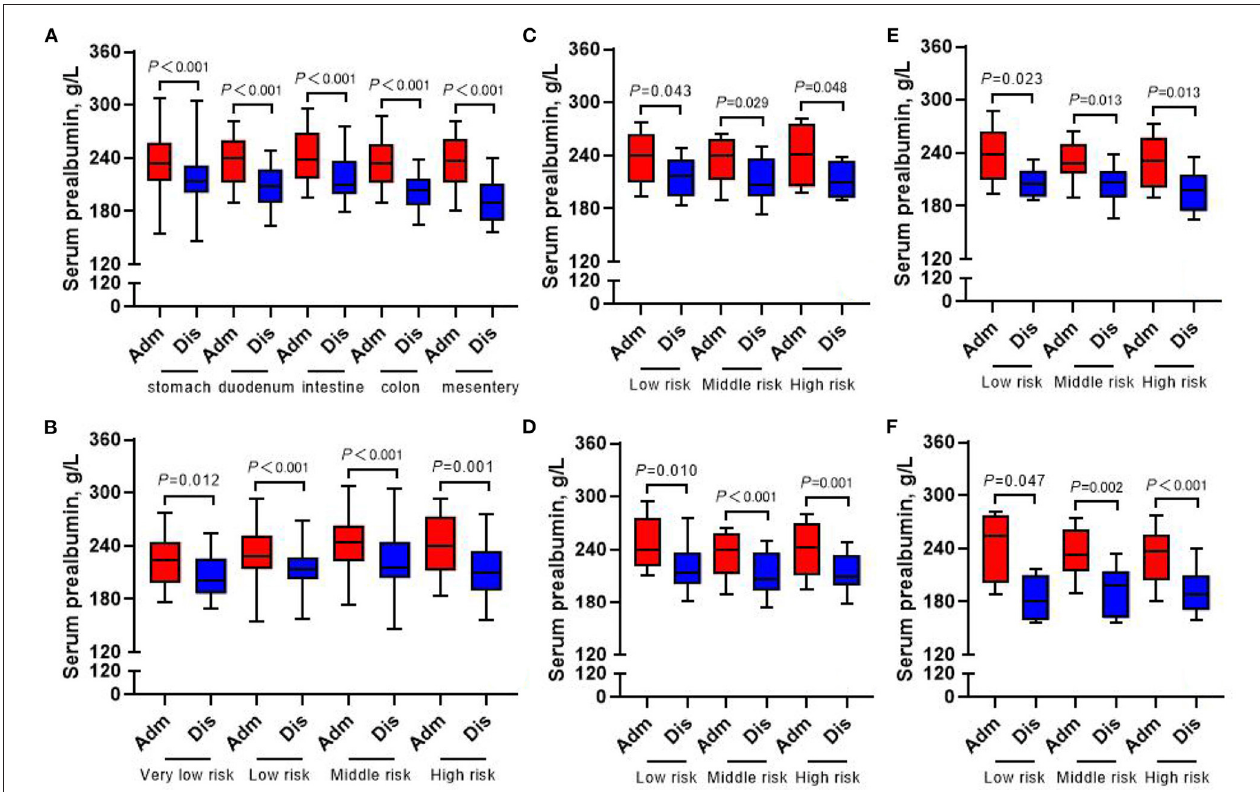
FIGURE 9 | Changes of serum prealbumin in 413 GIST patients at admission and discharge. (A) Total; (B) stomach; (C) duodenum; (D) intestine; (E) colorectal; (F) mesentery.